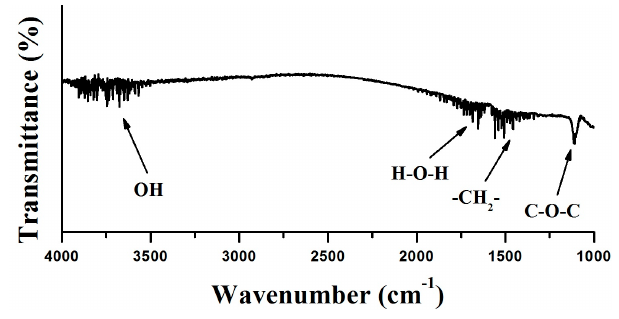
Figure 3. Fourier transform infrared spectroscopy (FTIR) analysis of PEG–Ho 2 O 3 NPs.